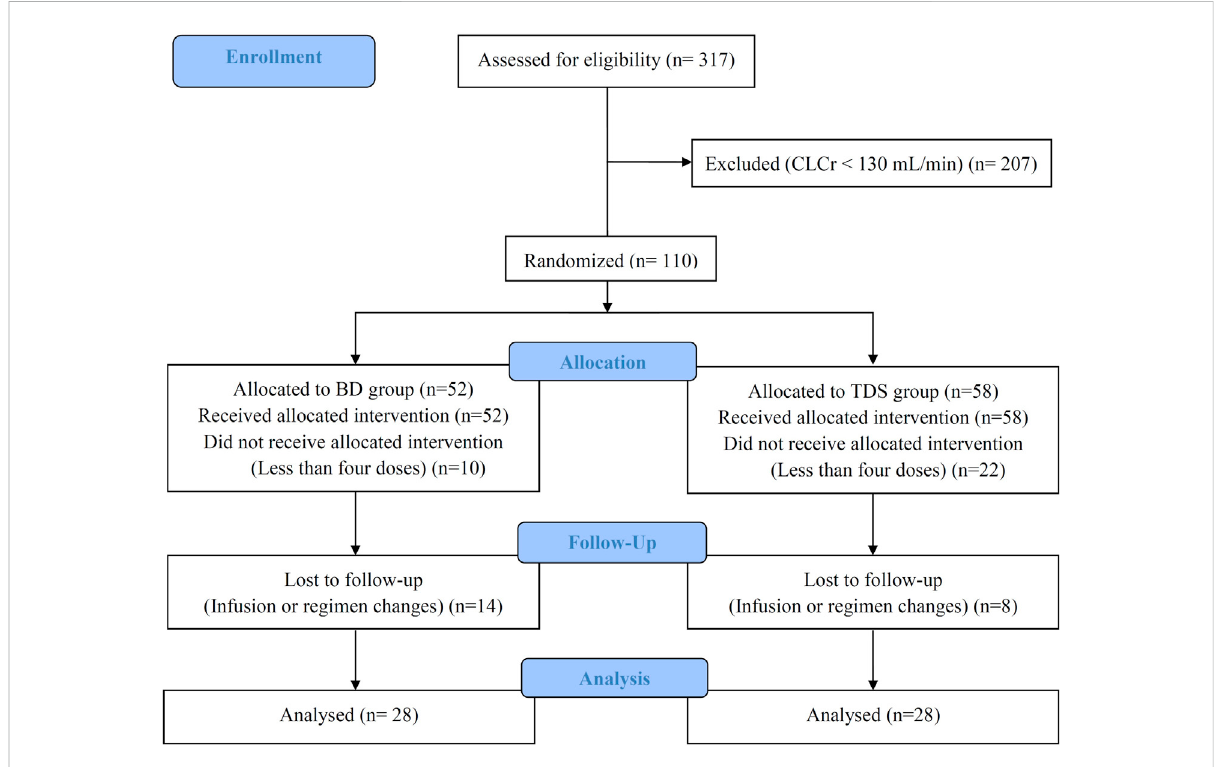
FIGURE 1 Consolidated standards of reporting trials (CONSORT) diagram of the